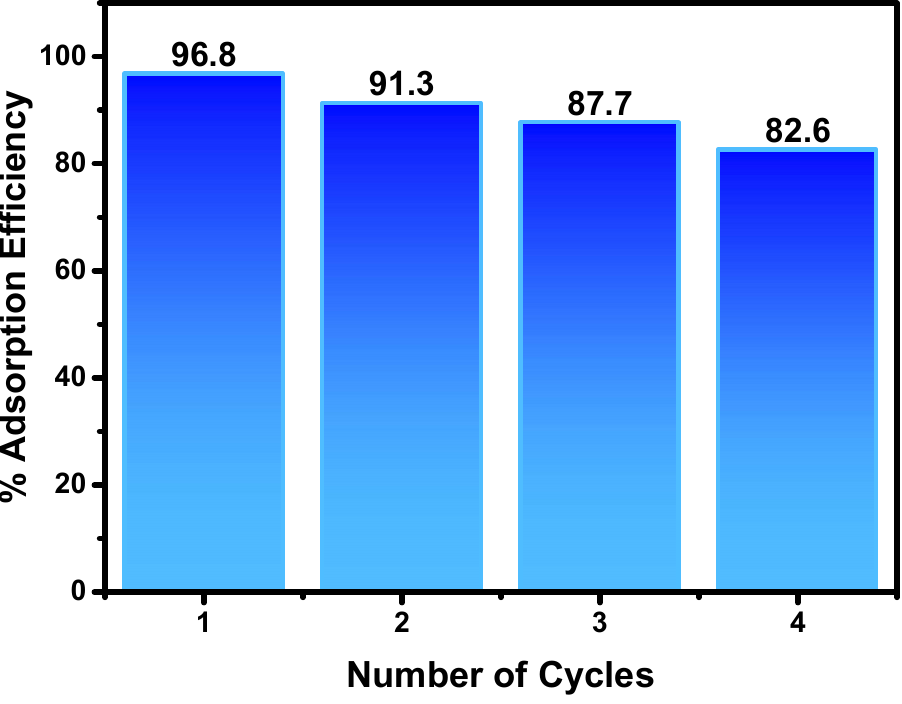
Figure 10. The adsorption–desorption process for four successive cycles.